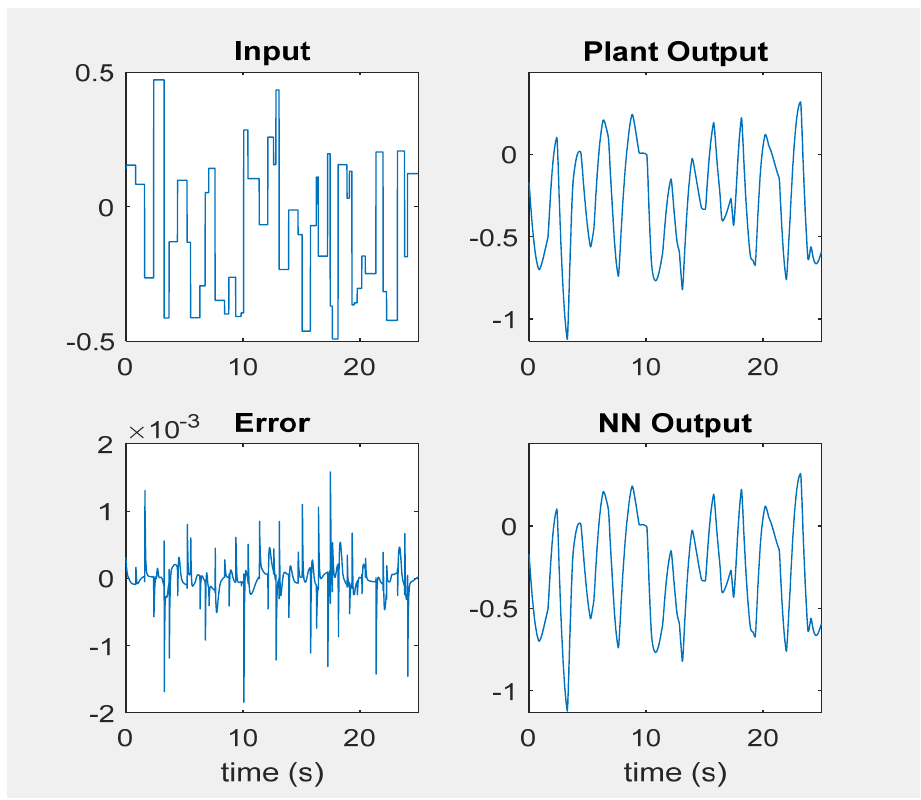
Figure 10. Testing data of neural network.